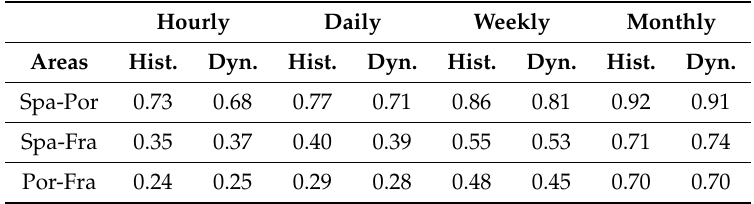
Table 11. Correlation comparison between historical data and dynamic approach. Hourly Daily Weekly Monthly Areas Hist. Dyn. Hist. Dyn.